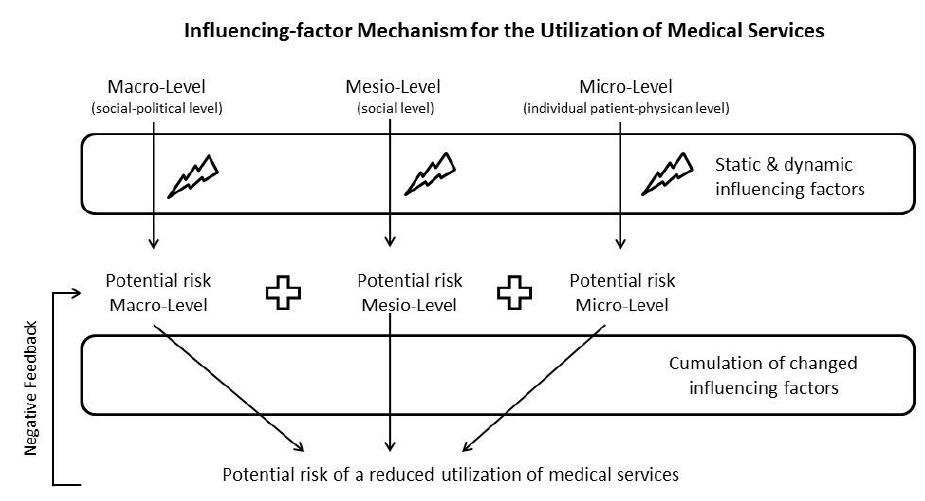
Figure 1. Influencing-factor mechanism of the utilization of healthcare services.